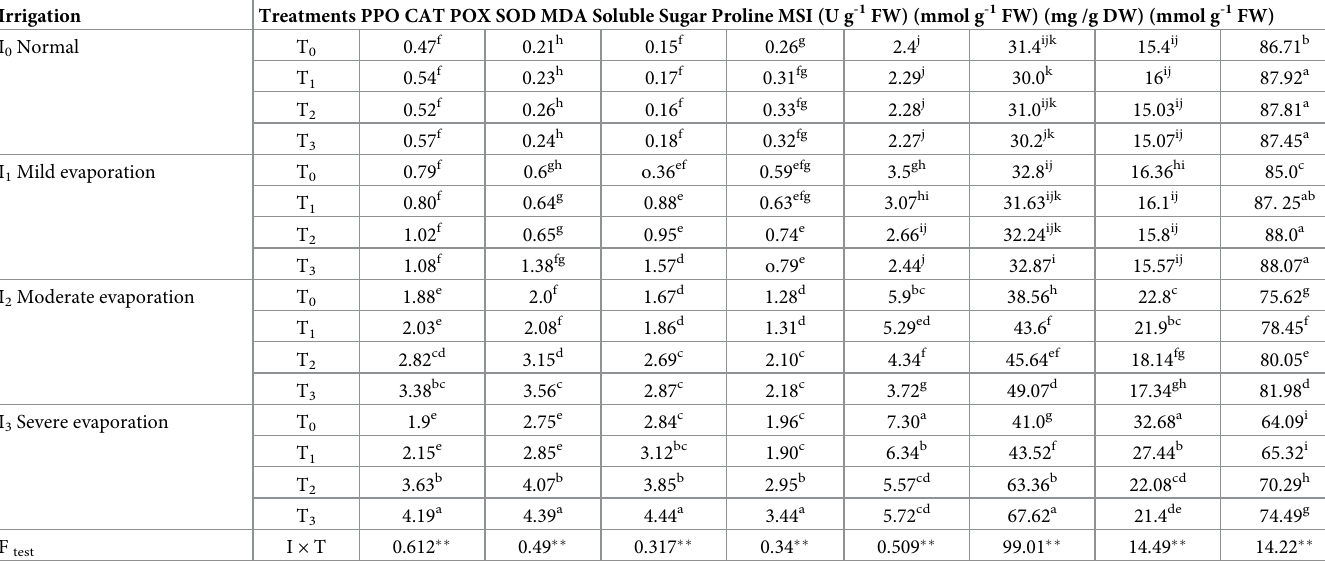
Table 7. Variation in biochemical attributes of canola with chemical fertilizers and plant growth regulators under different water regimes.